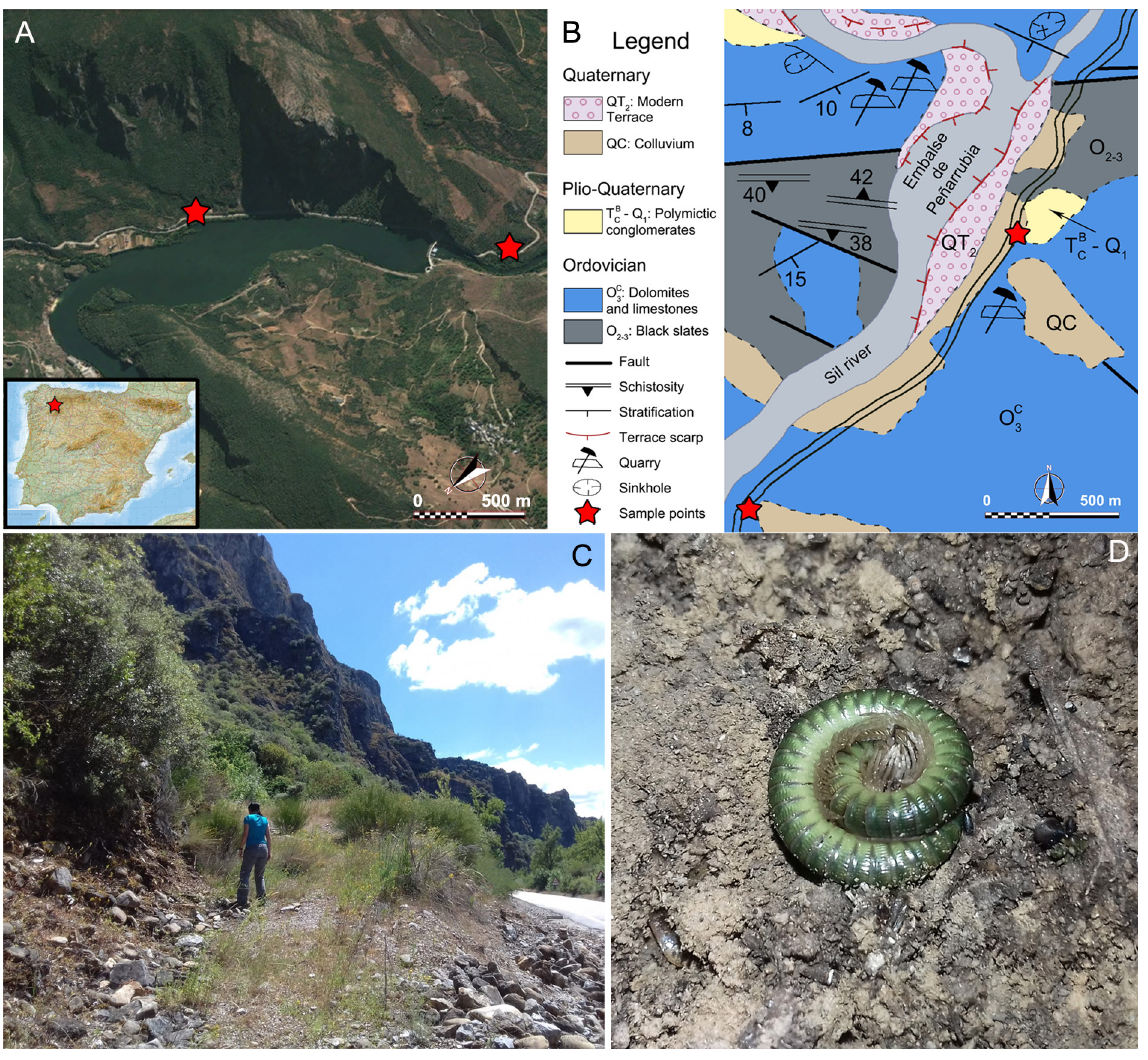
Fig. 1. Location and characteristics of the sampling points and a living specimen of Lusitanipus xanin sp. nov. A . Aerial view of the area at the Peñarrubia reservoir and its location in the Iberian Peninsula, with sampling point marked with a red star. B . Geological map of the area (modified from Abril Hurtado et al . 1982), with sampling point marked by a red star. C . Aspect of the landscape where Lusitanipus xanin sp. nov. was collected. D . Living specimen of Lusitanipus xanin sp. nov. in a defensive position over a clay layer below the limestone pebbles where it was